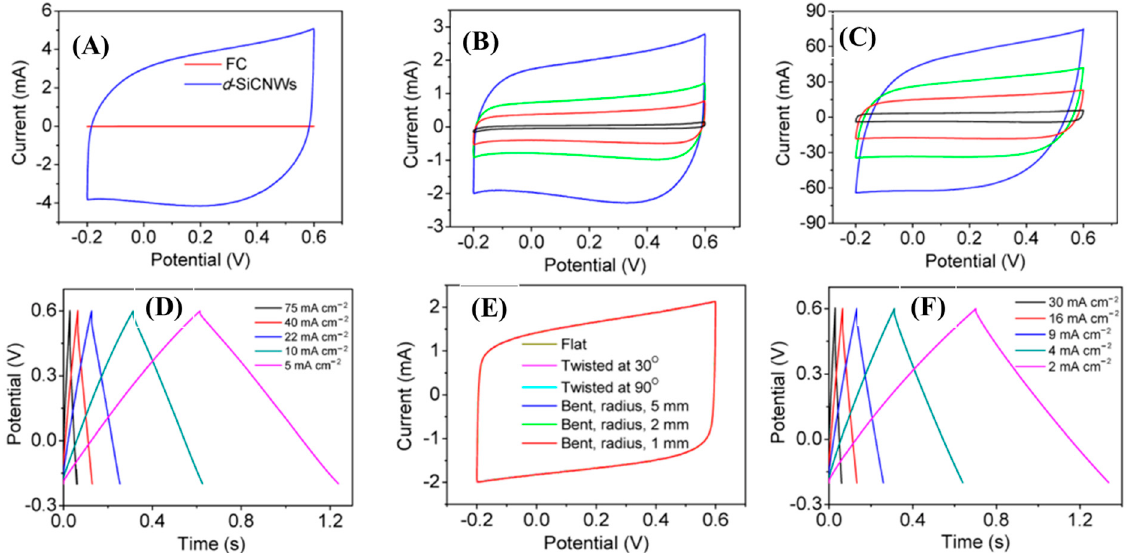
Figure 12. Electrochemical characterizations of N-doped SiC NWs: ( A ) CV comparative CV curves; ( B , C ) CV curves of pristine carbon cloths and SiC NWs at different scan rates (10–20,000 mV/s) within the potential window of − 0.2–0.6 V; ( D ) GCD curves at different current densities (5–75 mA/cm 2 ); ( E , F ) CV curves at different modes of deformation and GCD curves of all solid-state supercapacitors at various current densities (2–30 mA/cm 2 ) [107].